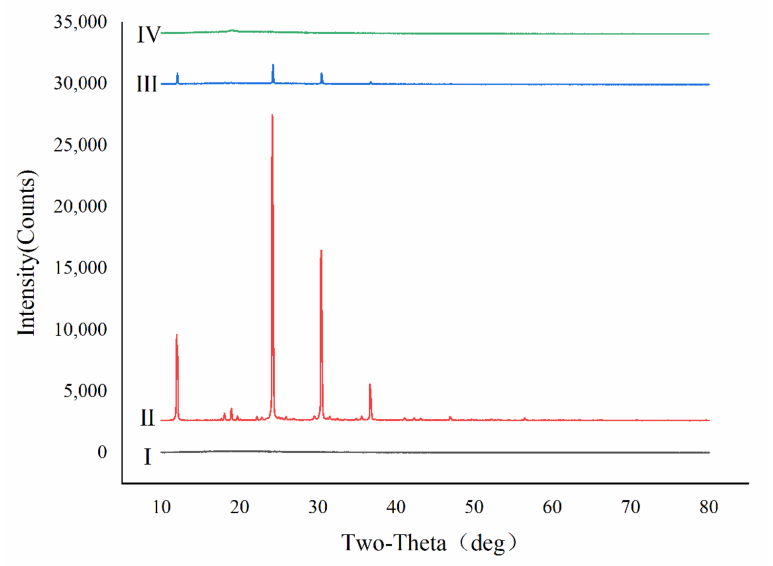
Figure 3. X-ray powder diffraction (XRPD) of ( I ) GM raw material, ( II ) Leu raw material, ( III ) physical mixture of GM and Leu powder raw materials, and ( IV ) GM spray-dried